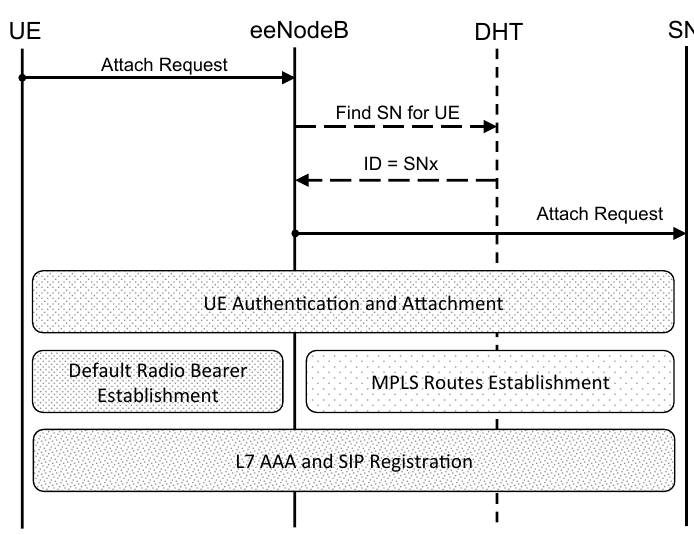
Figure 12. UE attach and SIP registration with